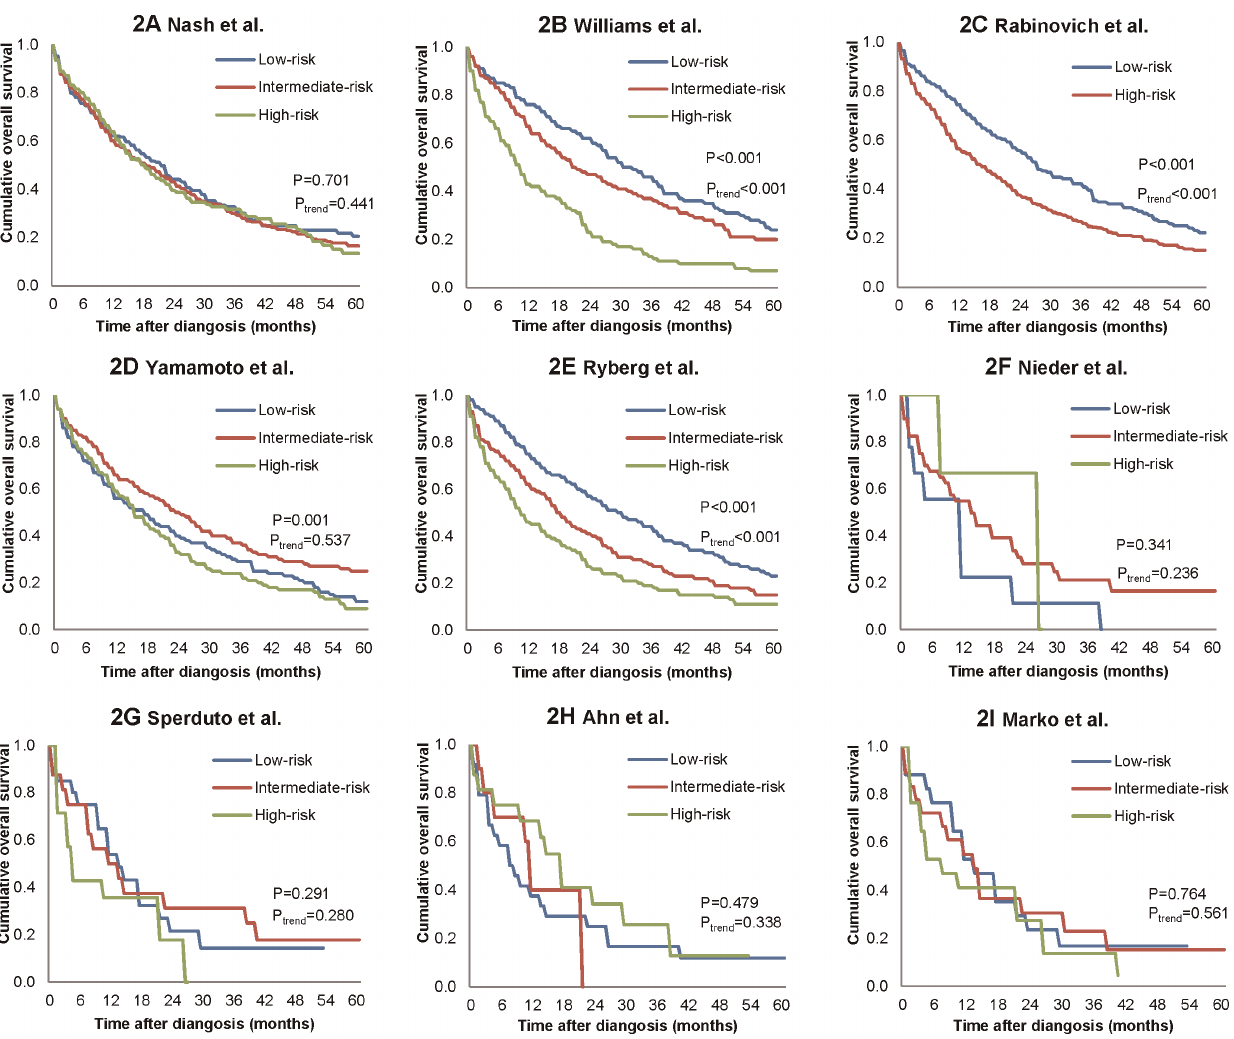
Figure 2. Kaplan Meier survival curves of low, intermediate and high-risk groups. Risk groups were defined by tertiles of risk scores of prediction models for patients with de novo metastatic breast